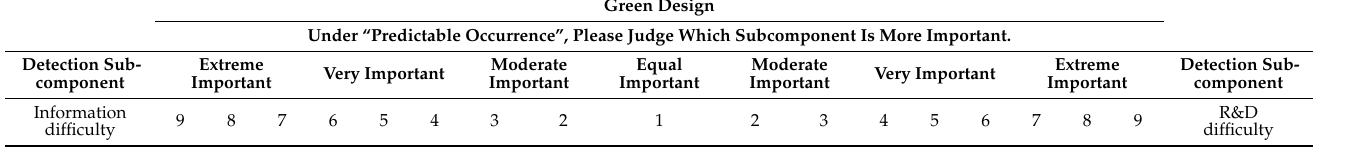
Table 1. ANP questionnaire of information—R&D difficulty under predictable occurrence for green design